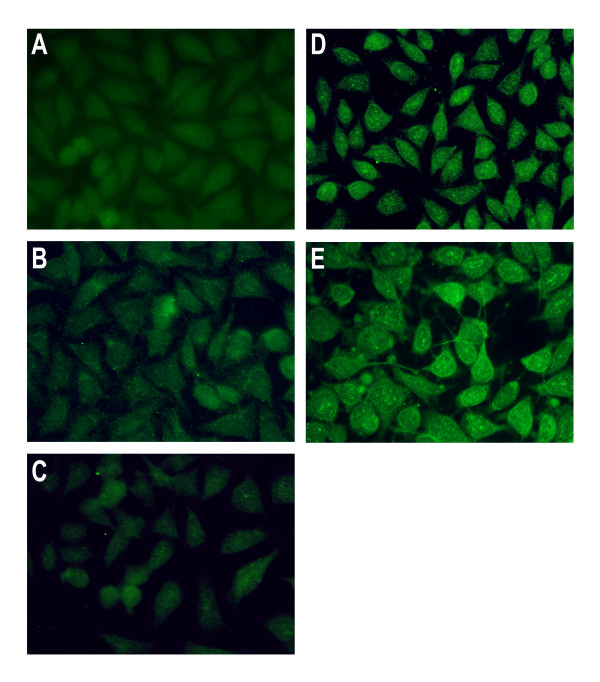
Immunostaining of PRL-3 (Abcam, Cambridge, UK) in DLD-1 cells cultured in DMEMF12 + 10% FBS (A), CM from foreskin fibroblasts (B), CM from normal colonic fibroblasts (C), CM from CAFs from a primary tumour (D), CM from CAFs from liver metastasis (E). Briefly, cells were fixed 5 min. in ice cold methanol, washed in PBS and incubated for 1 hour in blocking buffer 1:5 in PBS (horse serum and goat serum, 1:1 v/v). Then, overnight incubation with rabbit polyclonal antibody against PRL-3 (Sigma Aldrich). After washing steps, 1 hour incubation with Goat anti rabbit IgG (H+L) FITC conjugated (Jackson).